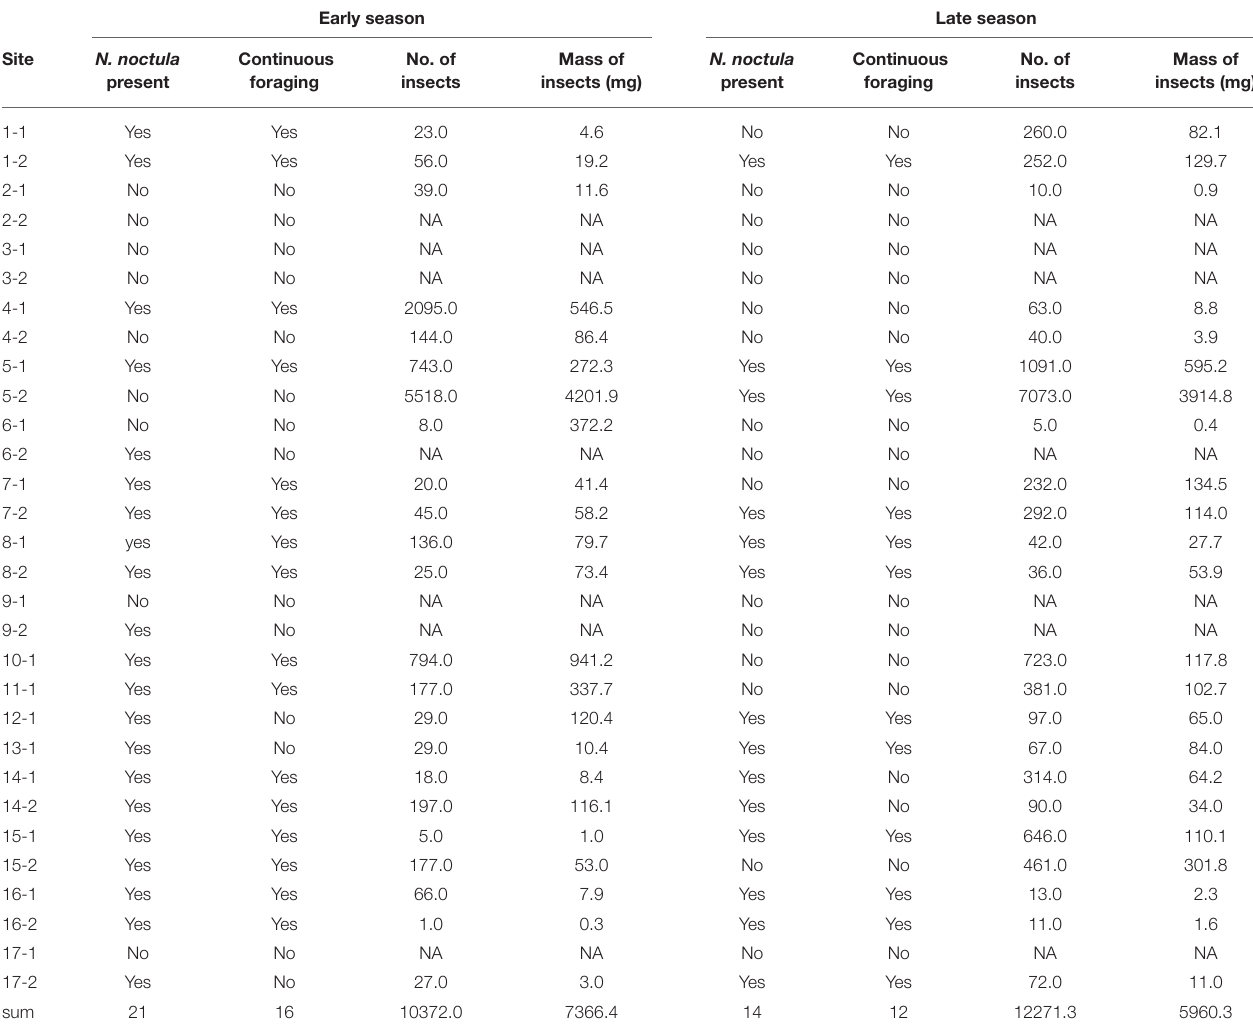
TABLE 1 | Presence and continuous foraging activity of N. noctula and total number and mass of insects at sampled